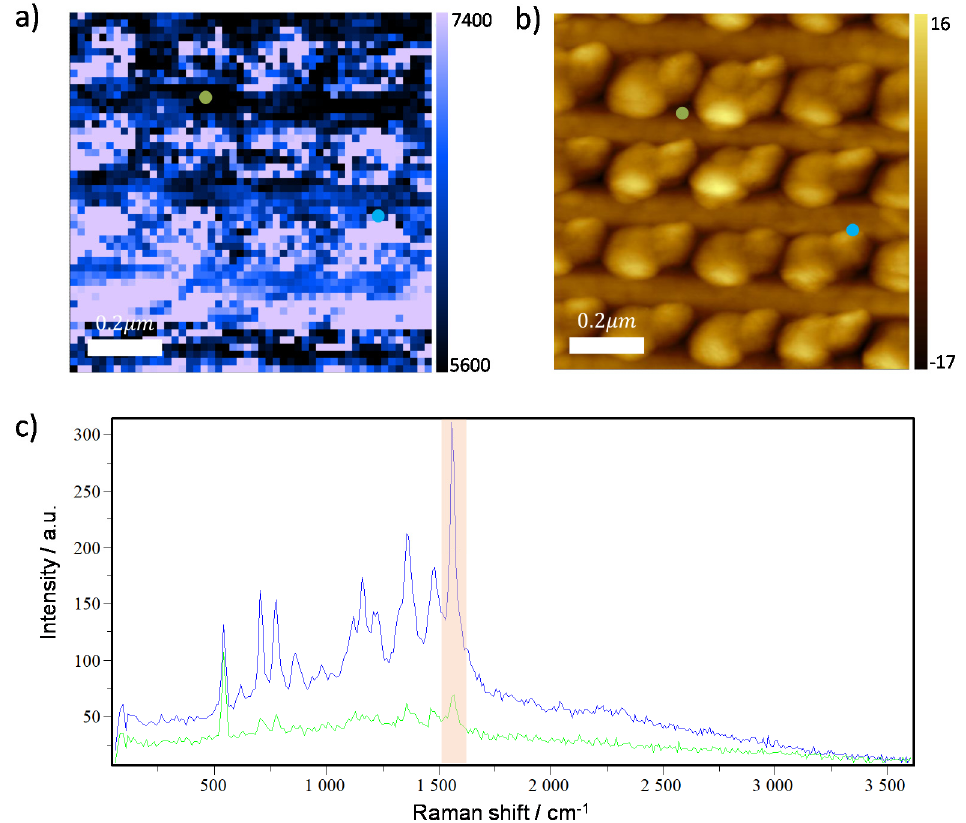
Figure 5. TERS experiment on the reference nanodisc—modified gold substrate. ( a ) TERS map, ( b ) Atomic-force microscopy AFM topography, and ( c ) corresponding Raman spectra taken from two different positions marked by blue and green dots in the TERS map. The TERS map is created using the most intense peak around 1535 cm − 1 as shown by the red shaded region in Figure 5c.